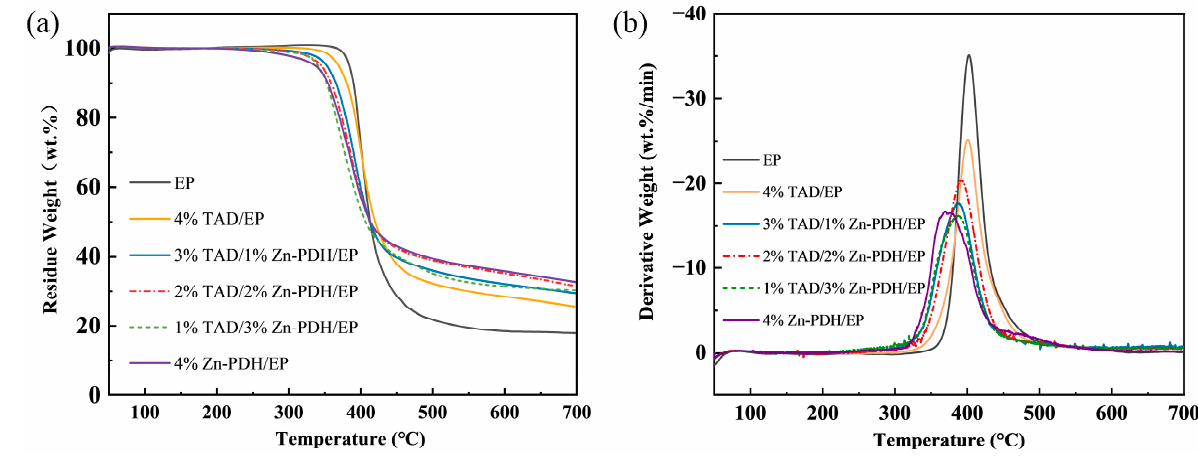
Figure 2. TGA ( a ) and DTG ( b ) curves of EP composites. Table 2. TGA of EP composites under N 2 conditions.